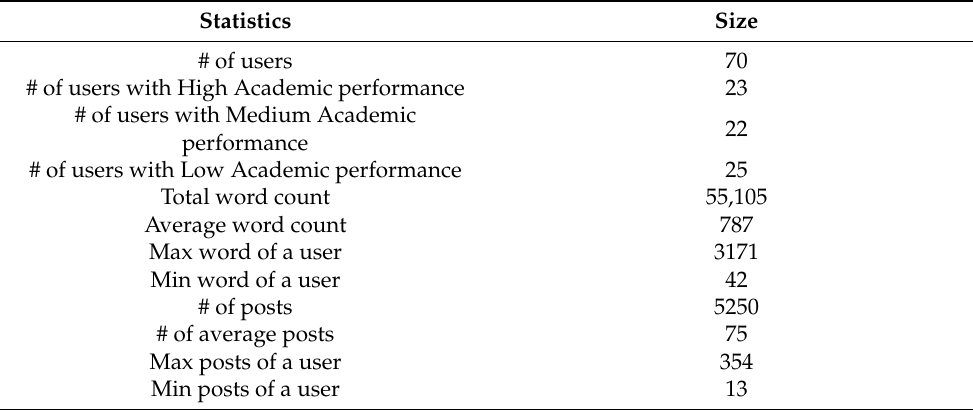
Table 5. Statistics of evaluation